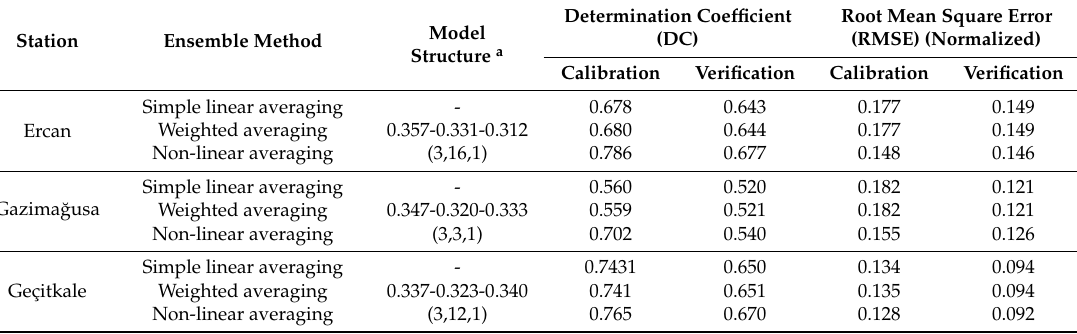
Table 7. Results of ensembles using linear weighted and non-linear averaging methods for scenario 1.